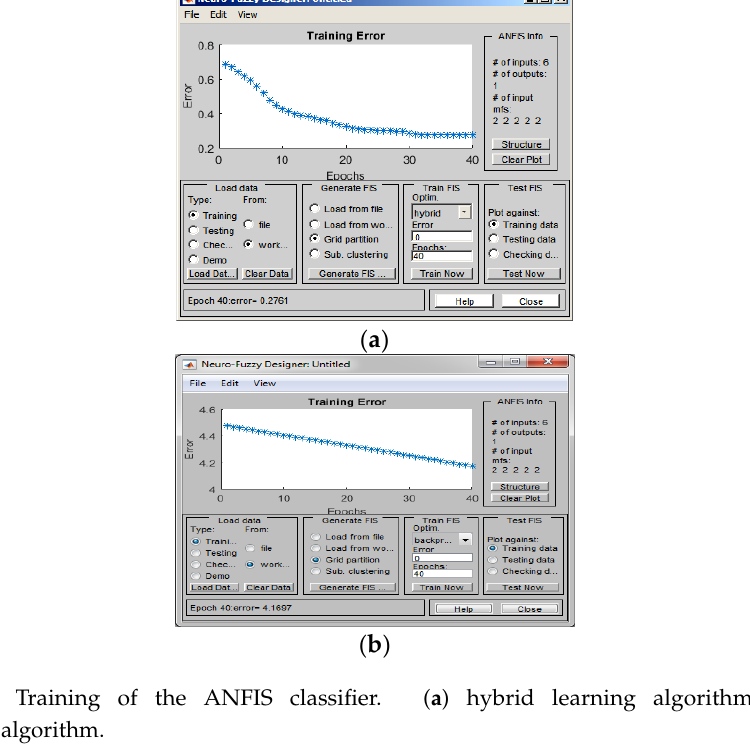
Figure 7. ANFIS Design Procedure. ( a ) Loading of training data set; ( b ) selection of ANFIS structure.